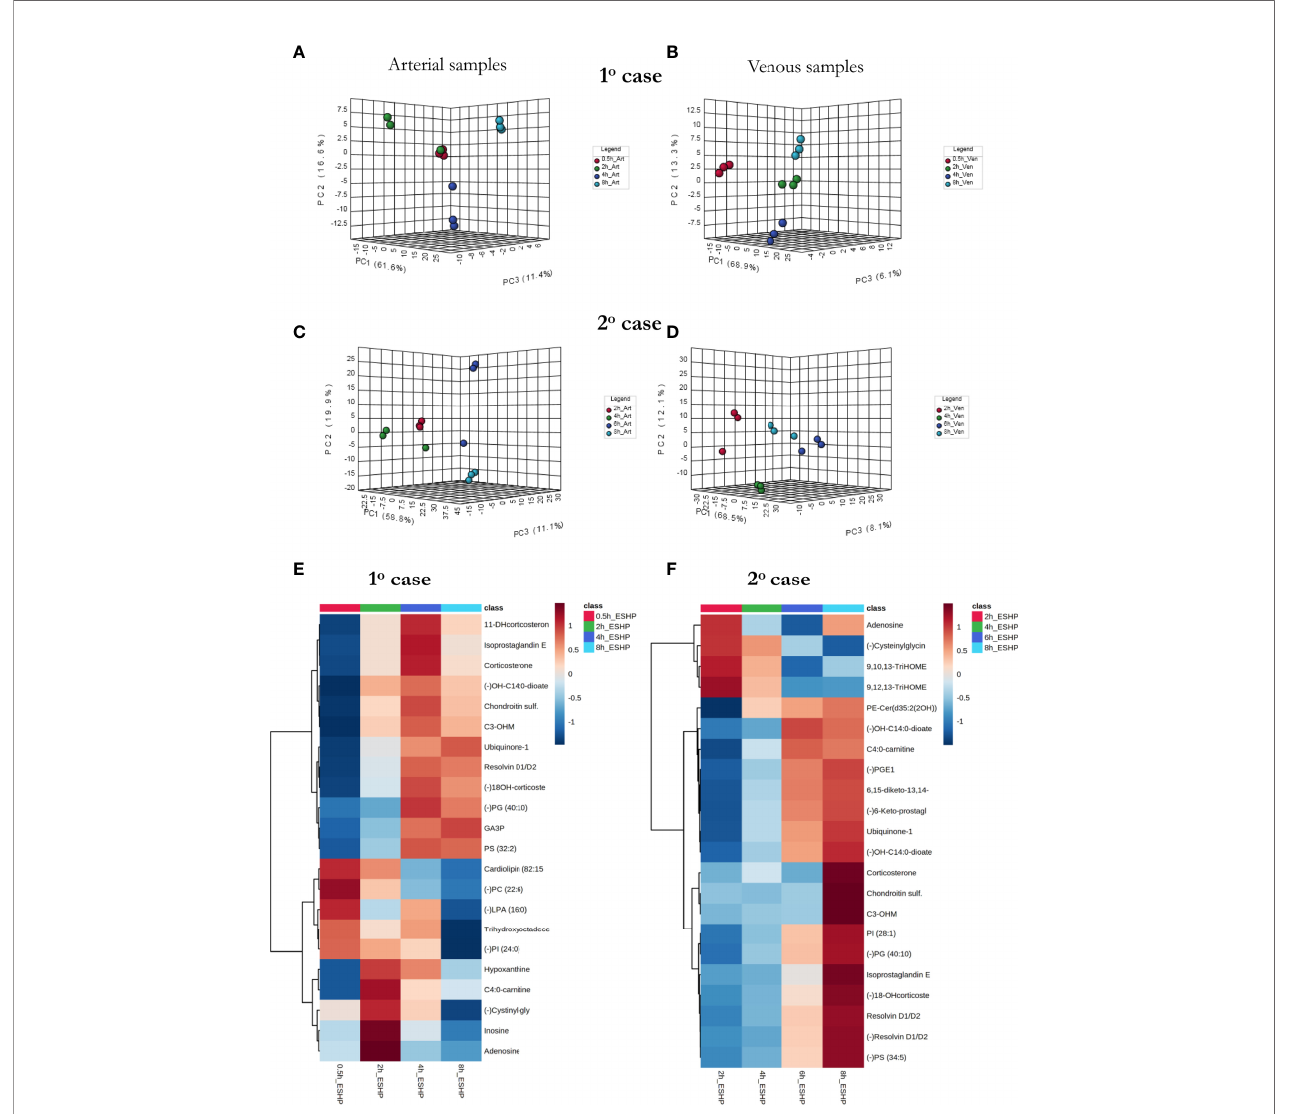
FIGURE 7 | The comprehensive picture of metabolomic alterations identi fi ed in perfusate and cardiac samples during clinical ESHP. (A – D) PCA score plots for metabolites detected in perfusate samples collected during clinical ESHP, and (E, F) heat maps depicting the most altered metabolites in human hearts over the course of ESHP. The plots were generated for metabolic features detected in 1 st case (A, B) and 2 nd case (C, D) . For clinical case 1: red — arterial/venous perfusate samples taken at 30 min of ESHP; green — arterial/venous perfusate samples taken at 2 h of ESHP; dark blue — arterial/venous perfusate samples taken at 4 h of ESHP; light blue — arterial/venous perfusate samples taken at 8 h of ESHP. For clinical case 2: red — arterial/venous perfusate samples taken at 2 h of ESHP; green — arterial/venous perfusate samples taken at 4 h of ESHP; dark blue — arterial/venous perfusate samples taken at 6 h of ESHP; light blue — arterial/venous perfusate samples taken at 8 h of ESHP. ( – ) refers to negative ionization mode. 11-DHcorticosterone – 11-Dehydrocorticosterone; OH-C14:0- dioate – 3-Hydroxytetradecane-dioic acid; C3-OHM – Cyclic 3-Hydroxymelatonin; 18-OHcorticosterone – 18-Hydroxycortico-sterone; GA3P – Glyceraldehyde- 3-phosphate; C4:0-carnitine – Butyrylcarnitine; Cysteinylglycin. – L-Cysteinylglycine disul fi de; 6,15-diketo-13,14. – 6,15-diketo-13,14-dihydro-prostaglandin F1 a ; 6-Keto-prostagl. – 6-Keto-prostaglandin F1 a